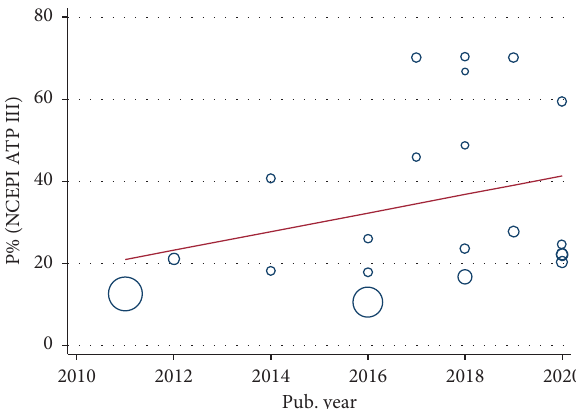
Figure 5: Meta-regression analysis based on published year using NCEP/ATP III